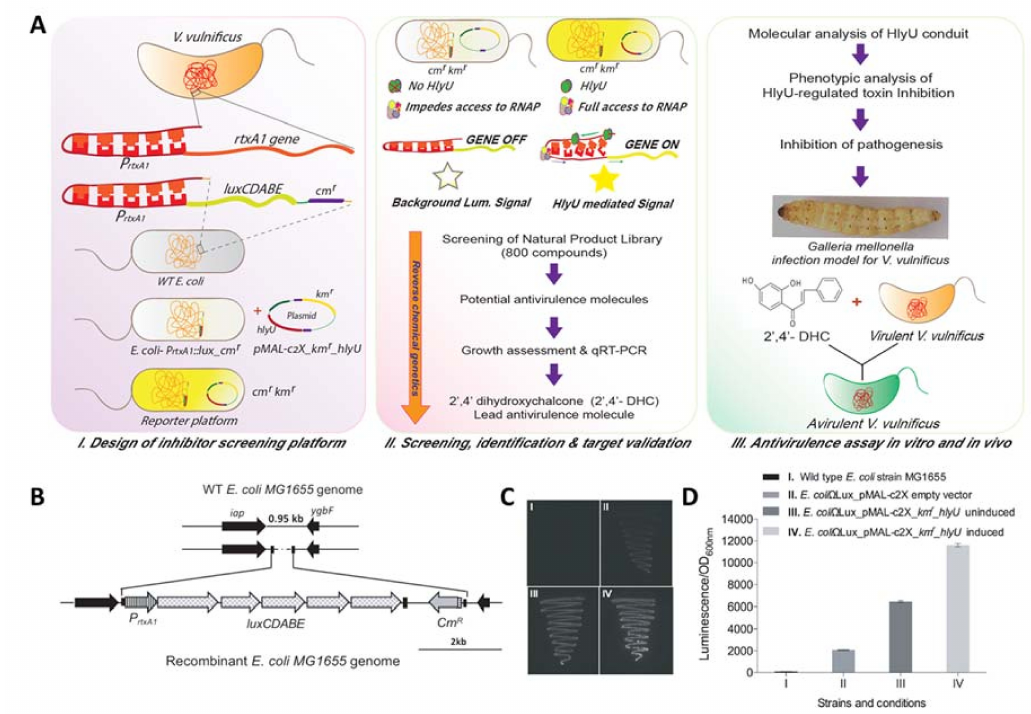
Figure 1. Development of a chromosomally integrated orthogonal inhibitor screening reporter platform and its evaluation, followed by the identification and validation of antivirulence inhibitor. ( A ) Overview of development of an orthogonal inhibitor/drug screening platform, screening, identification and validation of the antivirulence inhibitor; ( B ) schematic of integration for reporter cassette (P rtxA 1 ::luxCDABE-cm r ) in the intergenic region of E. coli using λ -red recombinase; ( C )